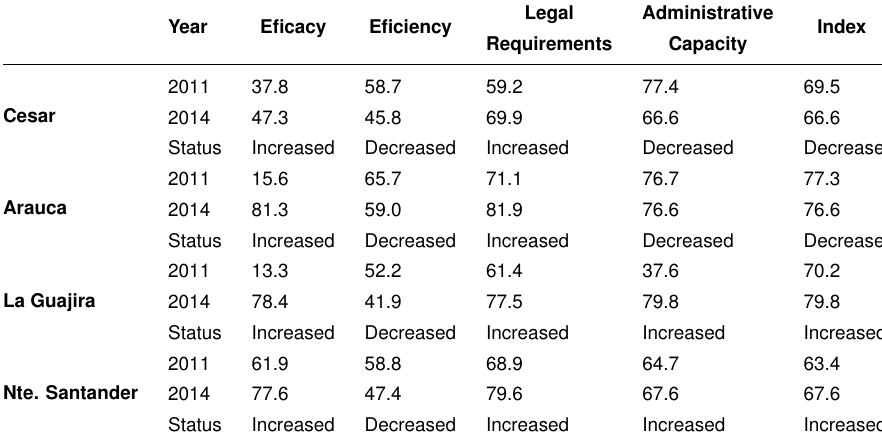
Table 1. Parameters of the Colombian state presence in the border with Venezuela